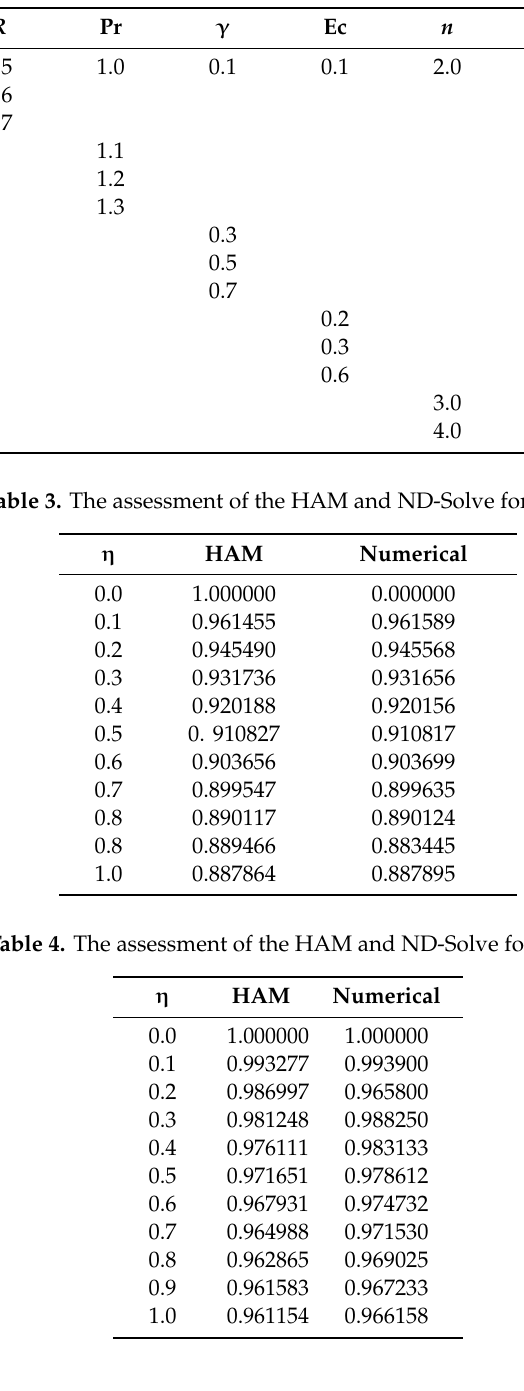
Table 2. The e ff ect of embedded parameters on Nu at 15th order approximations of the HAM.